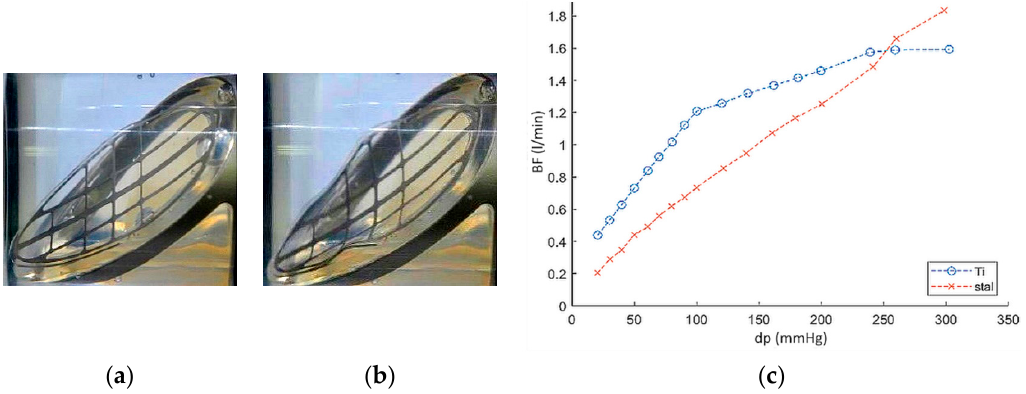
Figure 14. ZNP-S valve: leaflet deformation for ( a ) dp = 10 mmHg, ( b ) dp = 300 mmHg and ( c ) comparison of backflow (BF) for inflow valves with the frame made of titanium (Ti) and steel (S).